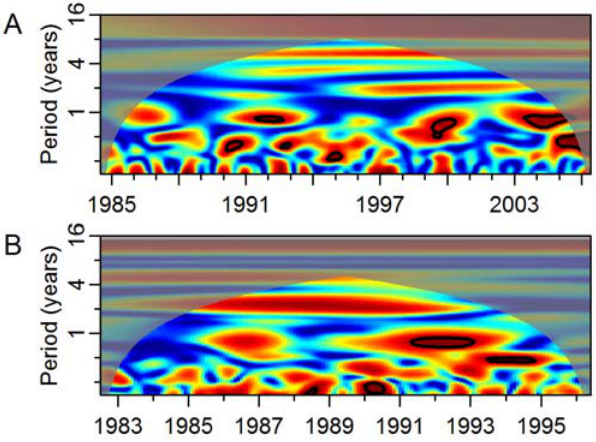
Figure 3. Coherence between ENSO and dengue in Mexico and Thailand. (A) Squared coherence plot of ENSO and dengue incidence in Mexico. (B) Squared coherence plot of ENSO and dengue incidence in Thailand. Features are as described in Figure 2A.